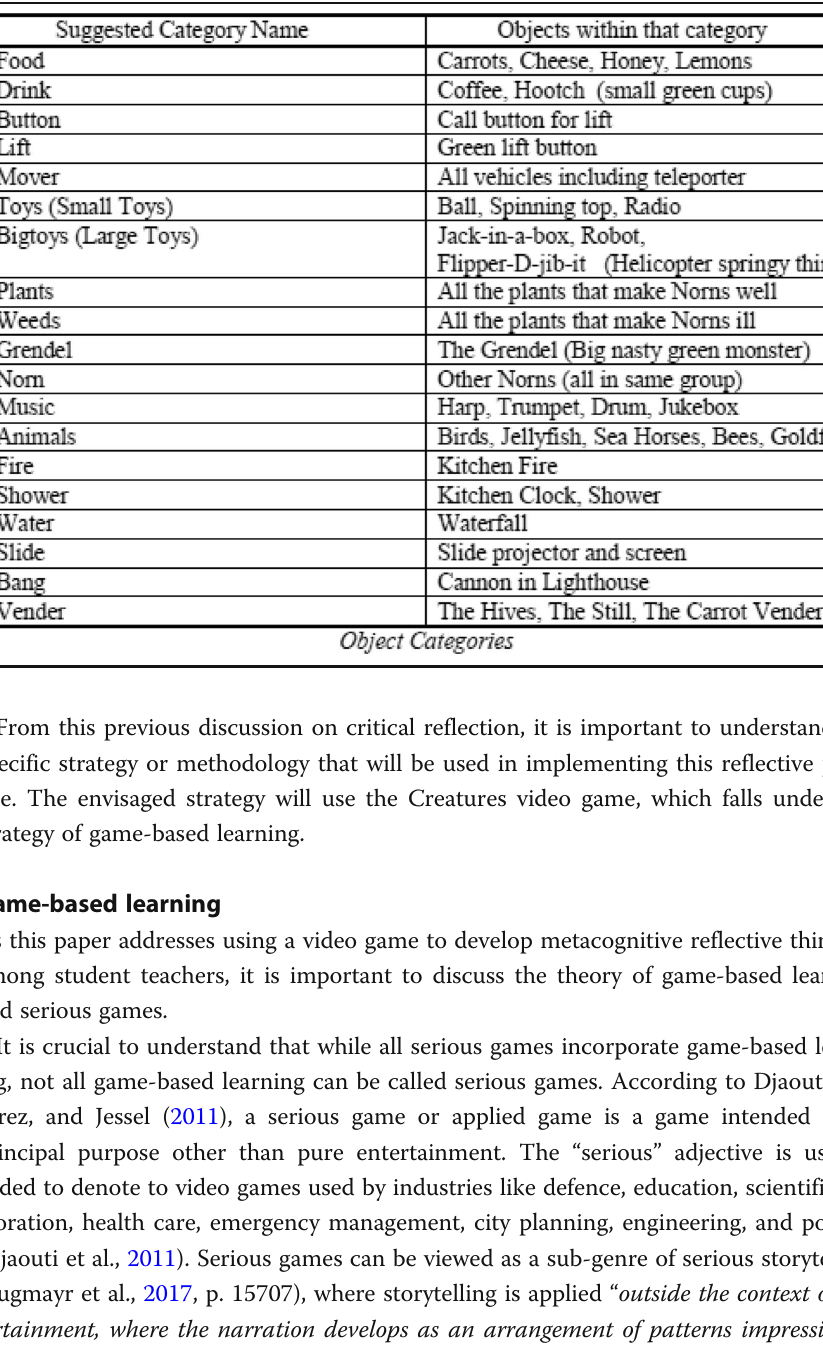
Table 1 Object categories in the Creatures game